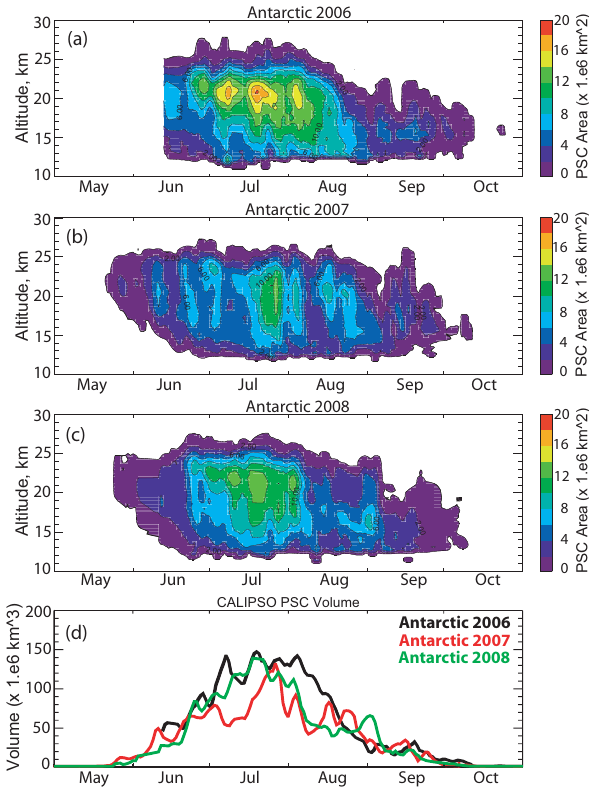
Fig. 10. PSC composition discrimination for the cloud scene from 24 July 2006 (same scene as shown in Fig. 2).